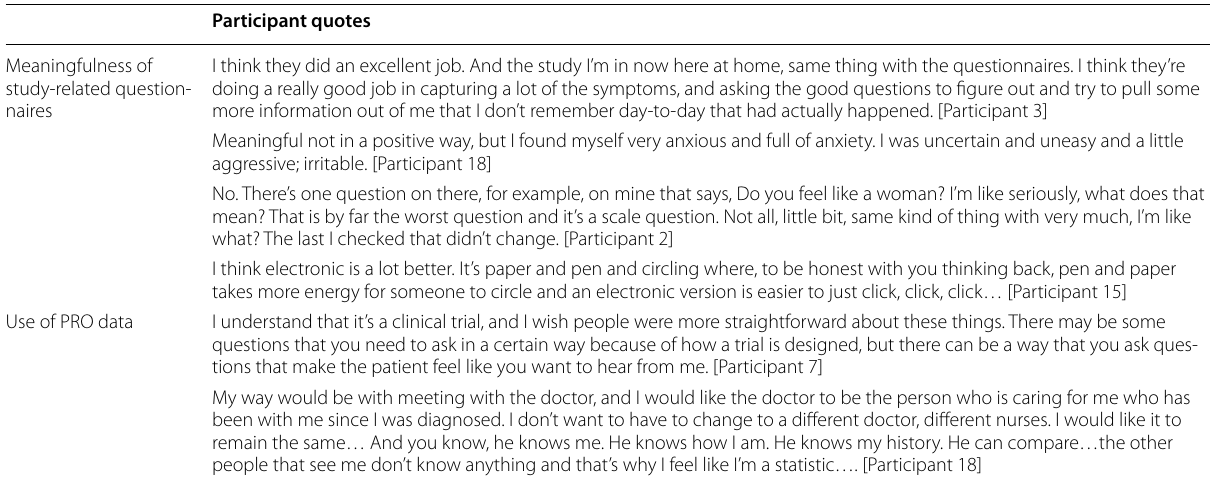
Table 5 Meaningfulness of clinical trial–related questionnaires to participants and their understanding of PRO